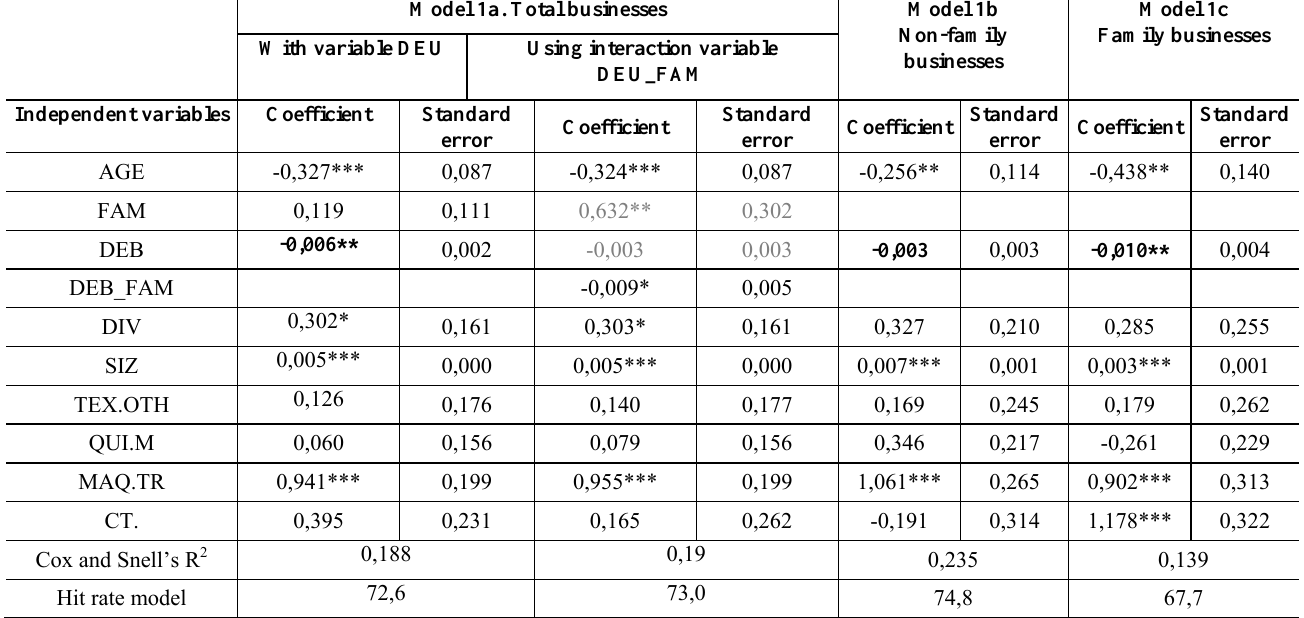
Table 9: Binary logistic analysis.Dependent variable EXP.